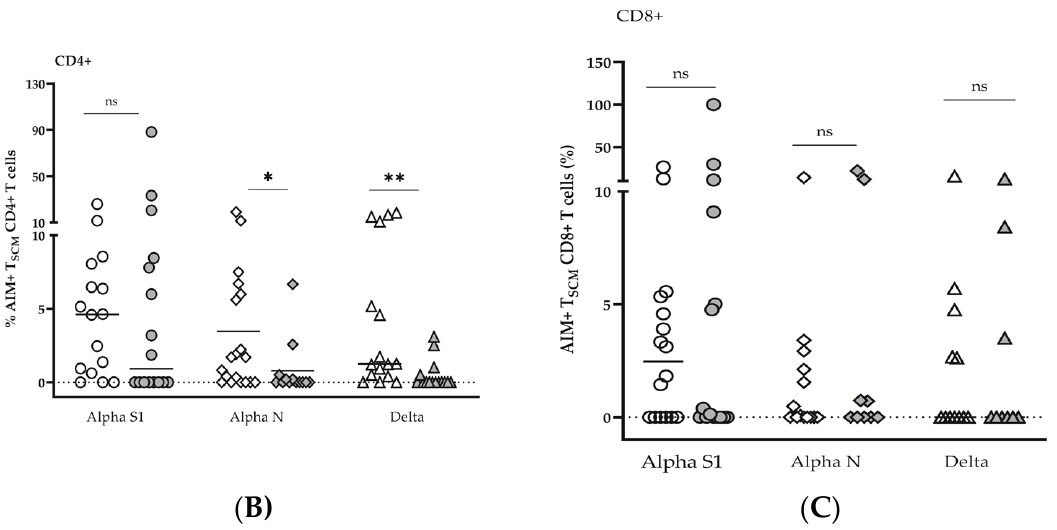
Figure 5. Detection of SARS-CoV2-specific CD4+ and CD8+ T SCM Gating strategies ( A ). CD4+ and CD8+ T SCM were determined as the share of naïve (CD45RA+CD197+) CD4+ or CD8+ T cells, co-expressing CD27 and CD95. Frequency of SARS-CoV-2 specific T SCM among CD4+ T SCM ( B ) and among CD8+ T SCM cells ( C ) The frequency of T SCM (CD45RA+CD197+CD27+CD95+) was determined after stimulation with the relevant peptide pools as described in Figure 2 as AIM+(CD137+CD69+CD154+) cells. Designations: T SCM specific to alpha S1 (circles), alpha N (diamonds) and delta (triangles) peptides, up to 9 months (open symbols) and beyond 9 months (grey symbols) after the infection. Statistical significance is determined by the Mann–Whitney test (ns, not significant, p > 0.05; * p < 0.05; ** p ≤ 0.0001).